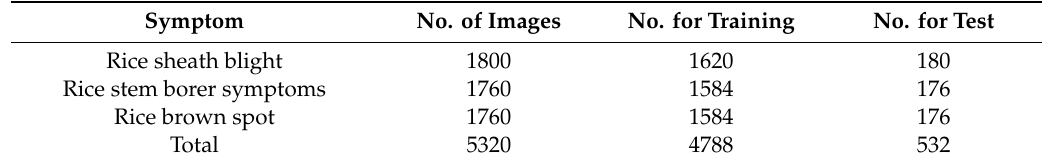
Table 1. Statistics of the images in the dataset collected in China, 2018. The images were used for training and testing the still-image models.